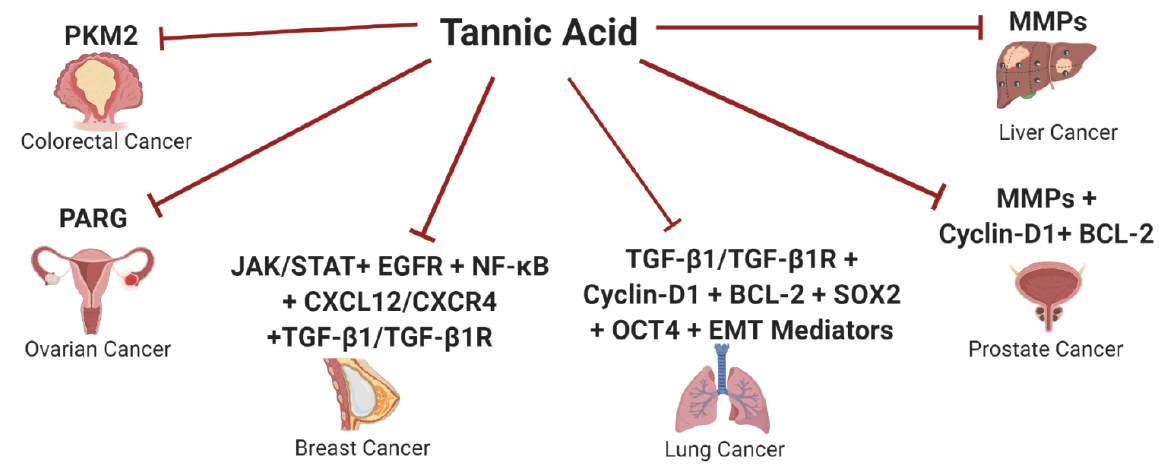
Figure 4. Schematic Representation of Tannic acid potential anticancer activity against several solid malignancies. This figure represents a summary of the potential role of Tannic acid (TA) as an anticancer agent through repressing several oncogenic signaling pathways and tumor-promoting factors in different solid malignancies such as colorectal, ovarian, breast, lung, prostate and liver